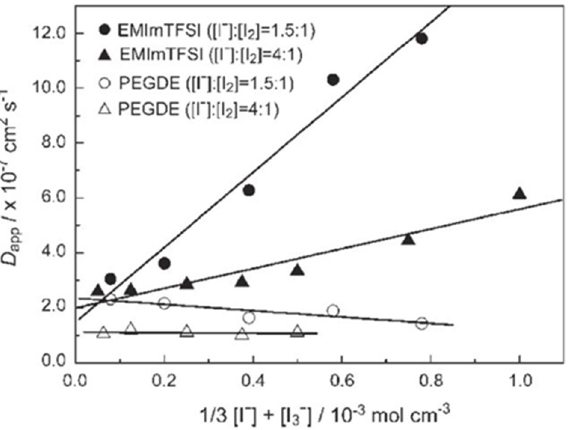
Figure 5. Relationship between D app and the concentration of the redox couple with different molar ratios dissolved in EMImTFSI and PEGDE, adapted from reference [54].